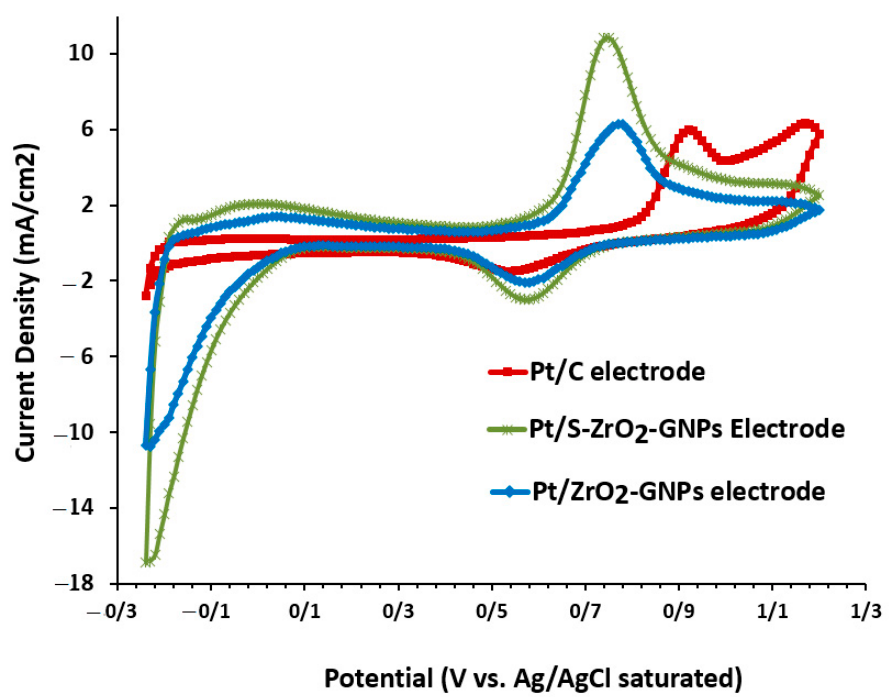
Figure 9. CO stripping results for Pt/S-ZrO 2 -GNPs, Pt/ZrO 2 -GNPs, and Pt/C electrodes in 𝑆𝑂 + 1 M 𝐶𝐻 𝐶𝐻 𝑂𝐻 solution, scan rate: 50 mV s (cid:2879)(cid:2869) at 25 0.5 M 𝐻 (cid:2870) (cid:2872) (cid:2871) (cid:2870)